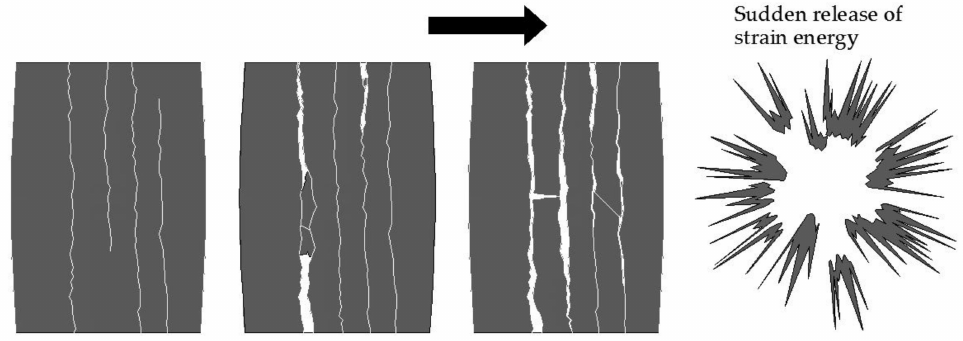
Figure 12. Sketch showing the creep stress induced deterioration in a sample of anthracite. The arrow indicates the progression of structural